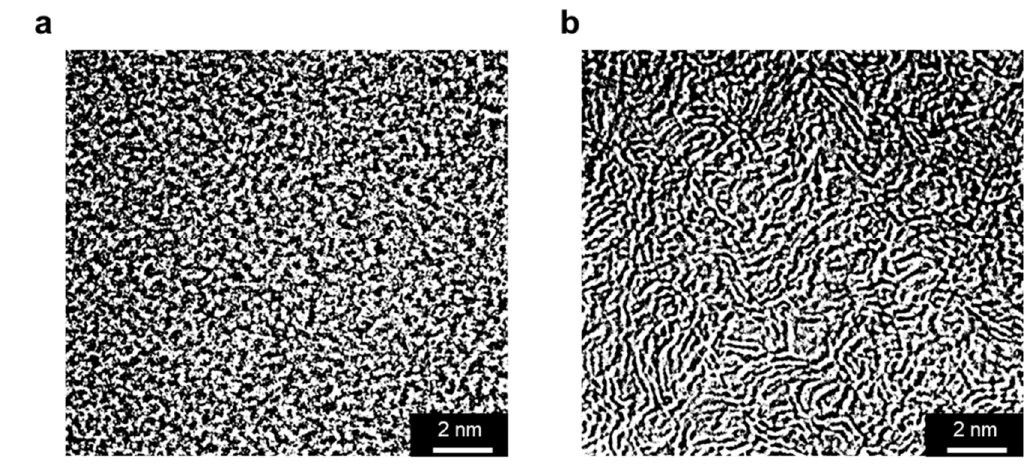
Figure 9. HRTEM images of: ( a ) CMSM 550 sample (gate sieving) and ( b ) CMS adsorbent (tubular sieving) (reproduced with permission from [75]).